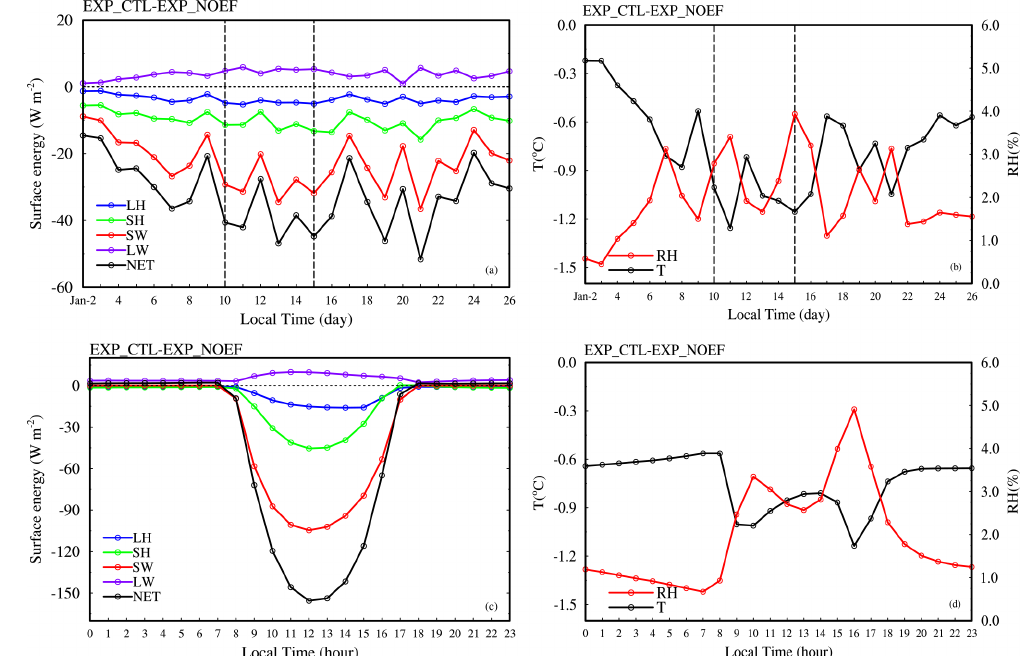
Figure 6. Time series of aerosol-induced daily change in (a) surface energy budget (SH, LH, LW radiation, SW radiation, and net energy flux, Wm − 2 ) and (b) meteorological variables (2m temperature ( ◦ C), 2m RH (%)) averaged for the BTH region (36–42 ◦ N, 113–120 ◦ E) during 2–26 January. Time series of aerosol-induced diurnal change of (c) surface energy budget and (d) meteorological variables averaged for the BTH region and the period 10–15 January 2013. LH is latent heat, LW is long-wave radiation, SH is sensible heat, SW is shortwave radiation, and NET is the sum of the total energy